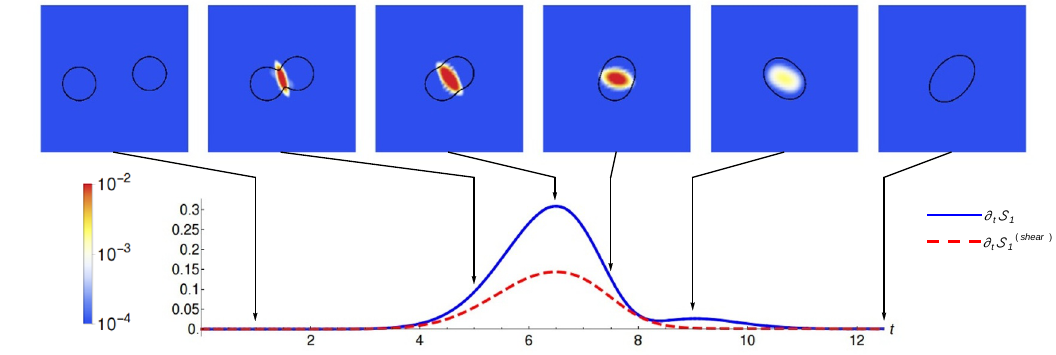
Figure 7 . Entropy production during a collision with fusion into a stable black bar. The (cid:12)rst, large fusion peak is followed by a smaller peak for the thermalization to the black bar. The height of this second peak is comparable to that in (cid:12)gure 6